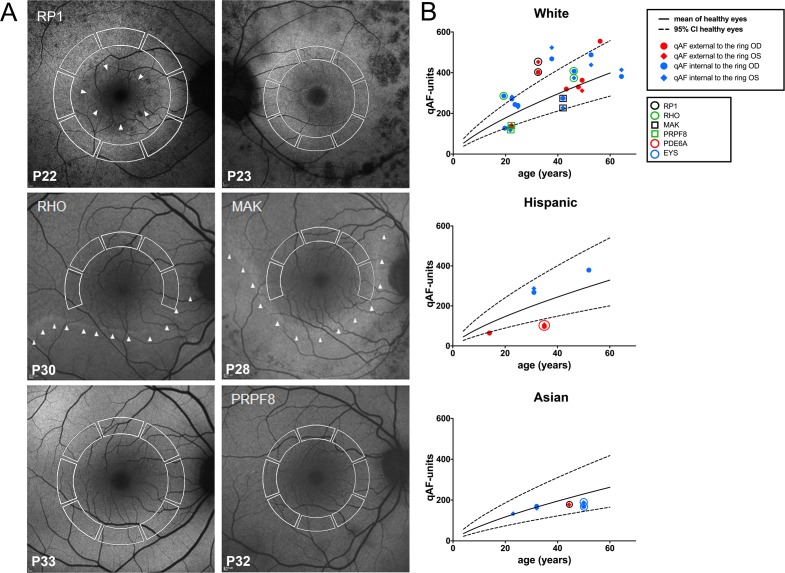
(A) Short-wavelength autofluorescence images of patients with RP assigned to qAF8 analysis. Mean GLs were recorded in eight circularly arranged segments (white lines) to calculate qAF8. The gene mutation is indicated in upper left of each fundus image if known. The arrowheads indicate the SW-AF border of the ring or crescent. P, patient number. (B) Mean qAF8 units are plotted as a function of age for each eye of patients with RP self-identified as White, Hispanic, and Asian. Symbols are color-coded for mutations and for values within and external to the ring. RP1, retinitis pigmentosa 1 gene; RHO, rhodopsin gene; MAK, male germ cell-associated kinase gene; PRPF8, precursor mRNA-processing factor 8 gene; PDE6A, phosphodiesterase 6A gene; EYS, homologue of drosophila eyes shut gene. Mean (solid black line) and 95% CI (dashed line) of healthy eyes.